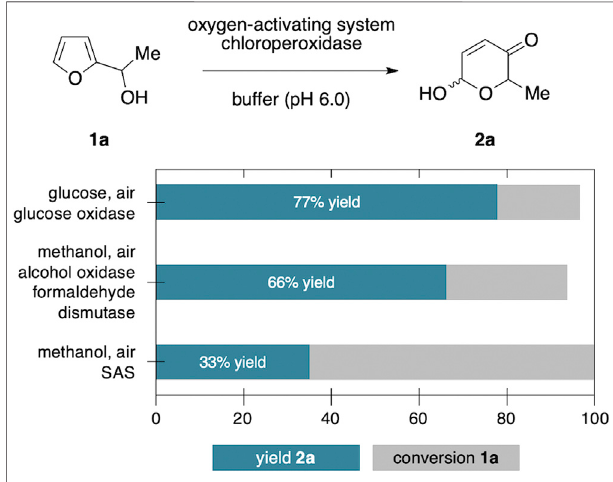
FIGURE 3 | Comparison of product selectivity between the different enzymatic Achmatowicz protocols.